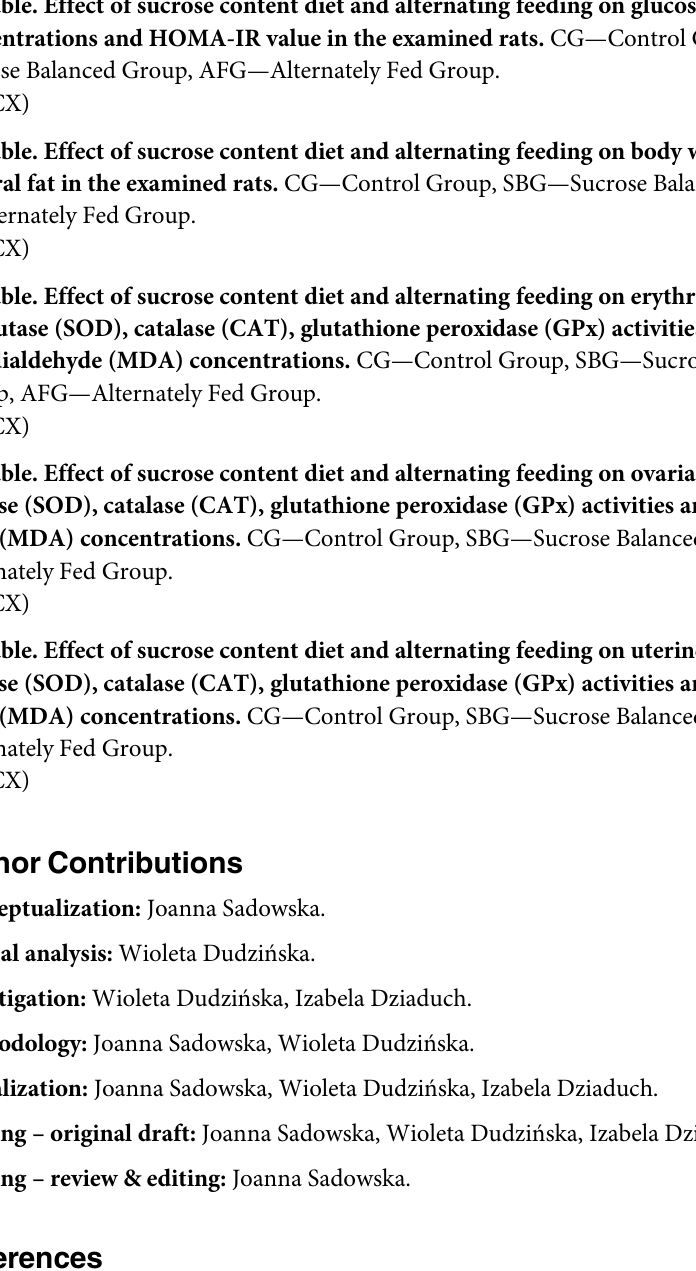
S2 Table. Effect of sucrose content diet and alternating. CG—Control Group, SBG—Sucrose Balanced Group, AFG—Alternately Fed Group. S3 Table. Effect of sucrose content diet and alternating feeding on glucose, insulin, lipid concentrations and HOMA-IR value in the examined rats. CG—Control Group, SBG— Sucrose Balanced Group, AFG—Alternately Fed Group. S4 Table. Effect of sucrose content diet and alternating feeding on body weight gain and visceral fat in the examined rats. CG—Control Group, SBG—Sucrose Balanced Group, AFG —Alternately Fed Group. S5 Table. Effect of sucrose content diet and alternating feeding on erythrocyte superoxide dismutase (SOD), catalase (CAT), glutathione peroxidase (GPx) activities and plasma mal- onyldialdehyde (MDA) concentrations. CG—Control Group, SBG—Sucrose Balanced Group, AFG—Alternately Fed Group. S6 Table. Effect of sucrose content diet and alternating feeding on ovarian superoxide dis- mutase (SOD), catalase (CAT), glutathione peroxidase (GPx) activities and malonyldialde- hyde (MDA) concentrations. CG—Control Group, SBG—Sucrose Balanced Group, AFG— Alternately Fed Group. S7 Table. Effect of sucrose content diet and alternating feeding on uterine superoxide dis- mutase (SOD), catalase (CAT), glutathione peroxidase (GPx) activities and malonyldialde- hyde (MDA) concentrations. CG—Control Group, SBG—Sucrose Balanced Group, AFG— Alternately Fed